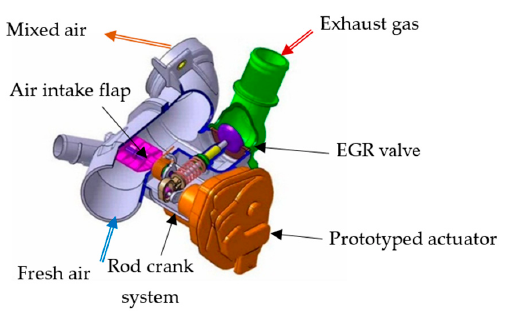
Figure 1. Air flow and EGR system of an internal combustion engine with the actuator prototype.